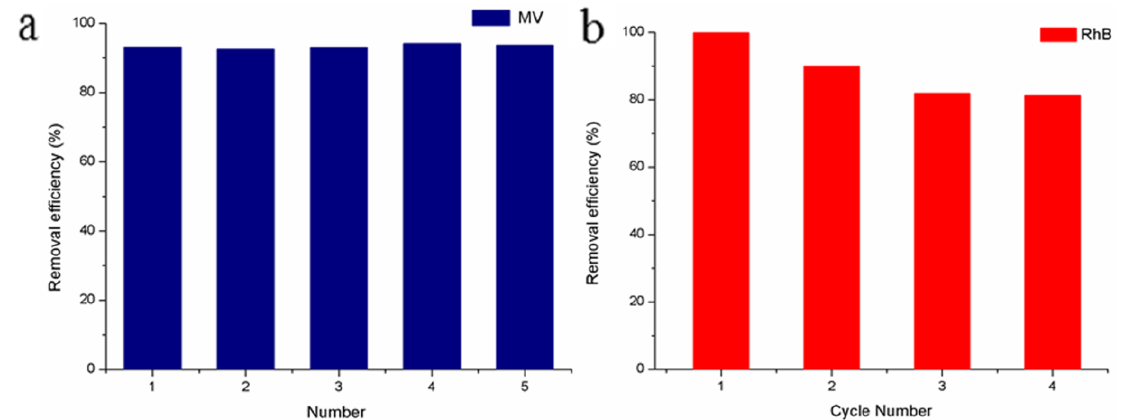
Figure 6. Repeatability ( a ) and reusability ( b ) of MSNs for adsorption of cationic dyes.